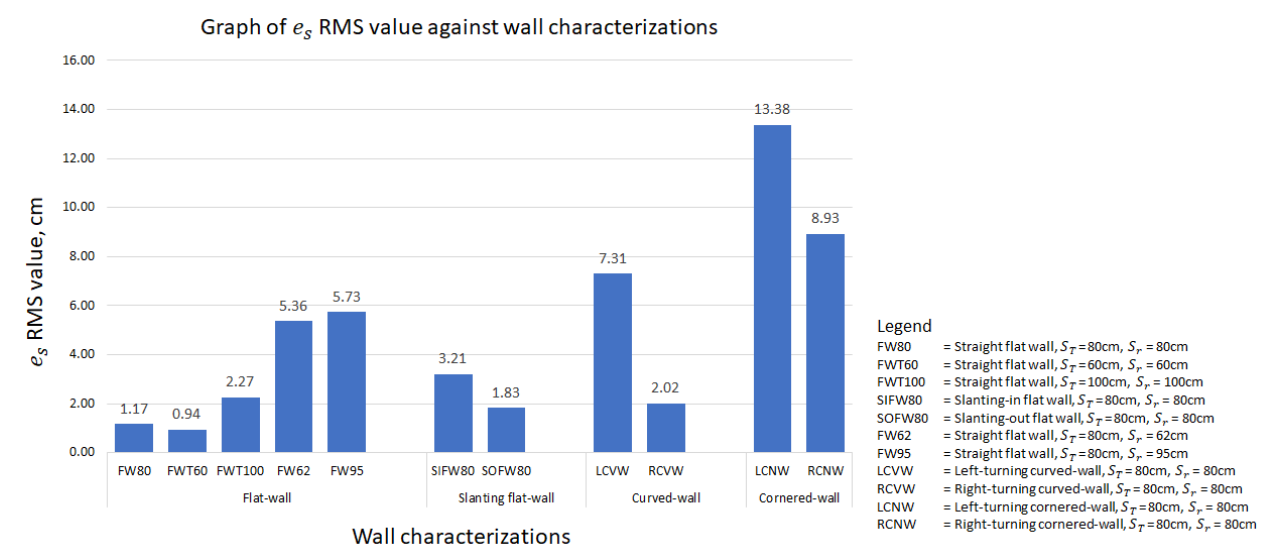
Figure 12. Graph of e s RMS value against different wall characterizations. For curved-walls and cornered-walls, the RMS value shows an increasing trend compared to flat-walls. Throughout both curved-wall and cornered-wall categories, left- turning cases have a higher RMS value compared to the right-turning cases. This is due to the working concept of the FLS and the position of the end-effector. In this paper, the end- effector is assumed to be attached to the left side of the robot platform. Hence, the proposed FLS will always attempt to drive the robot following the left side wall with a preset target distance. In such a configuration, e s always tends to increase during a left-turning case and decrease during a right-turning case. The robot platform also tends to travel with a slower velocity v x in right-turning cases due to the detection of the wall segment in front as an obstruction, which allows more time for the robot platform to react to e s . On the other hand, cornered-wall cases have the highest RMS value among all cases as the robot platform does not travel entirely according to the wall characterization. Instead of following the wall in a 90 ◦ trajectory turn at the corner, the robot platform travelled in an arc trajectory as shown in Figure 11h,i. Eventually, a large e s value was generated at the corner position and contributed to the high RMS value. Future work is to be carried out to further adapt the proposed FLS to